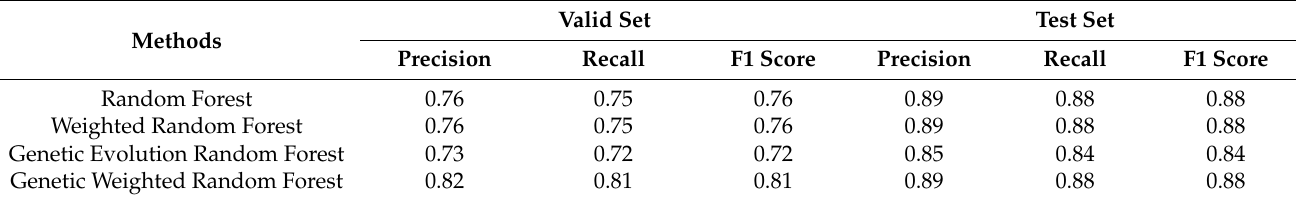
Figure 10. The boxplot of our models in five datasets. Table 3. The Precision, Recall and F1 score of our model in 10 independent experiments. No.